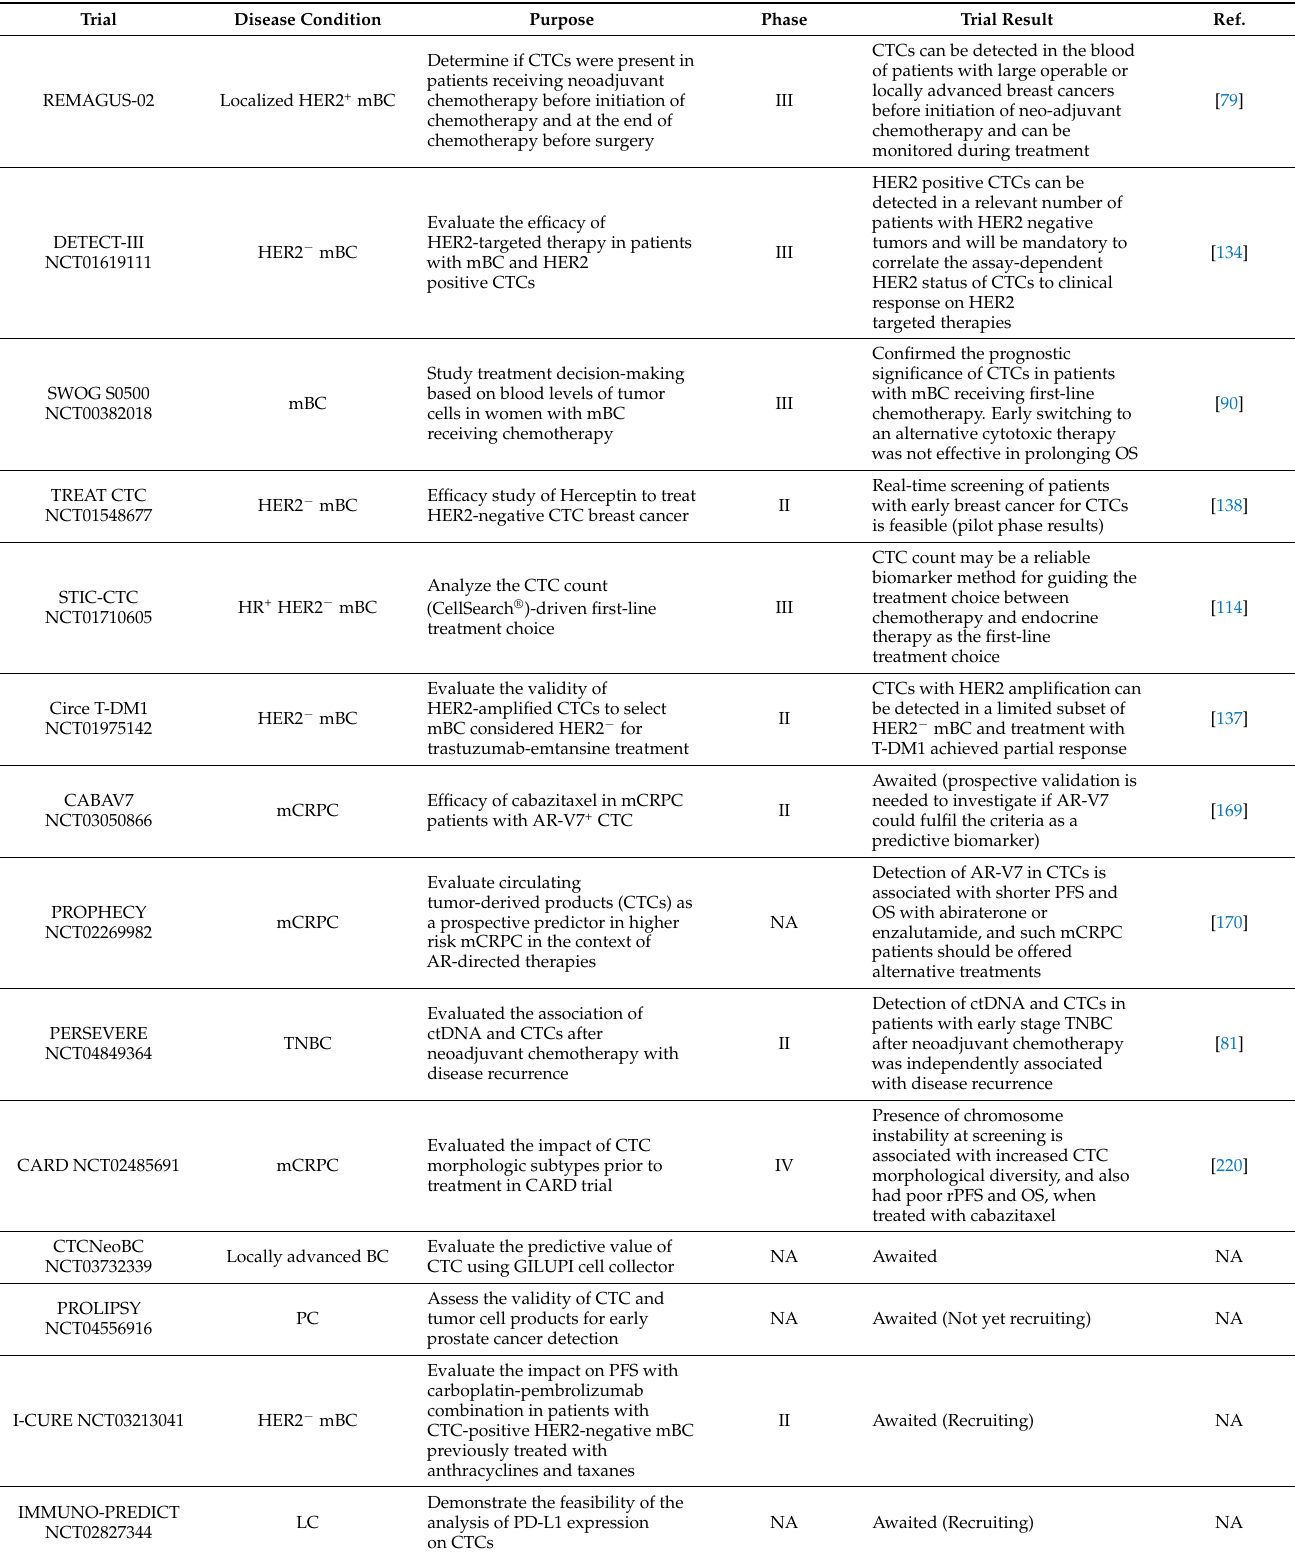
Table 2. Clinical trials evaluating the predictive role of circulating tumor